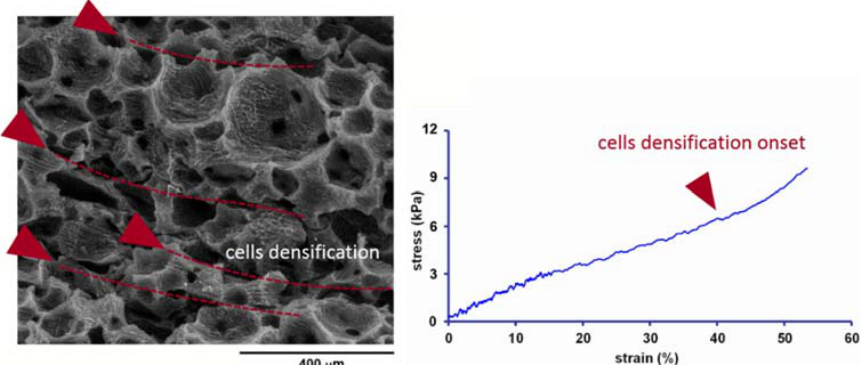
Figure 7. In-SEM compression test of the sample PVA-MFC-10, showing the mechanism of